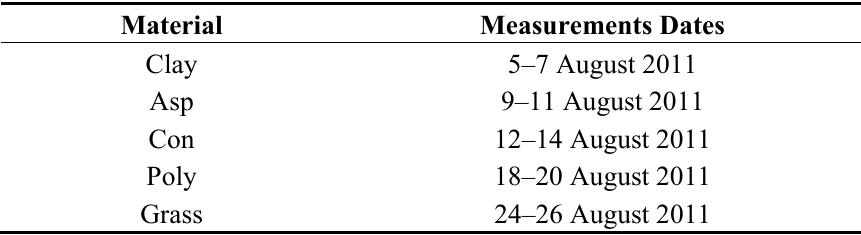
Table 1. Coverage materials and measurement dates. Summer season.